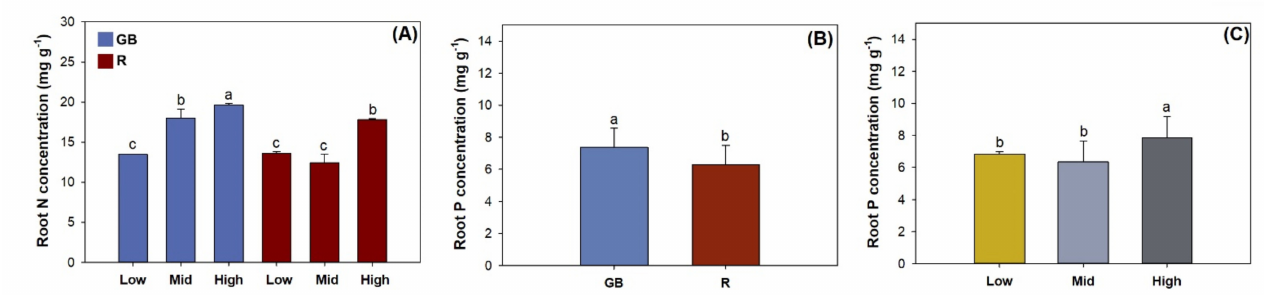
Figure 6. Nitrogen (N) and phosphorus (P) concentrations in Pinus pumila seedlings subjected to green-and-blue light (GB) and red-light enriched spectra (R) in low, middle, and high half-pot fertilities. Error bars indicate standard deviations. Different letters above the bars indicate significant difference according to Duncan test at the 0.05 level. ( A ) root N concentration of seedlings subjected to combined light spectra and half-pot fertility; ( B ) root P concentration in response to light spectra; ( C ) root P concentration in response to half-pot fetility.